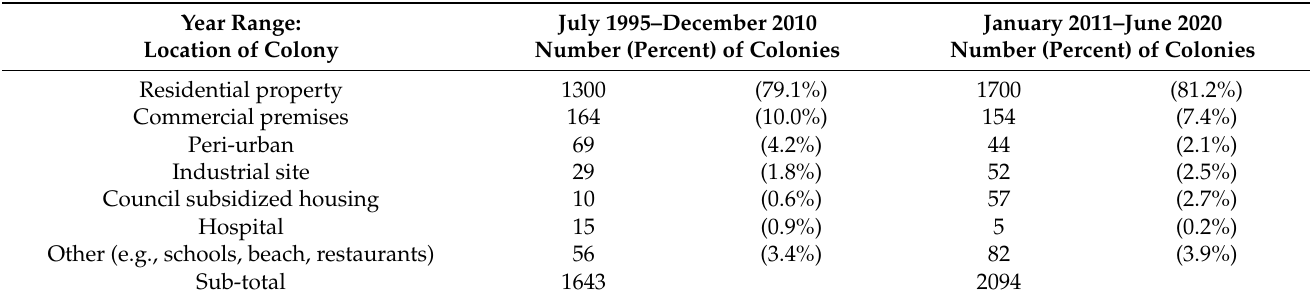
Table 1. Cat colonies (total n = 3737) resolved by Lonely Miaow, Auckland, New Zealand,